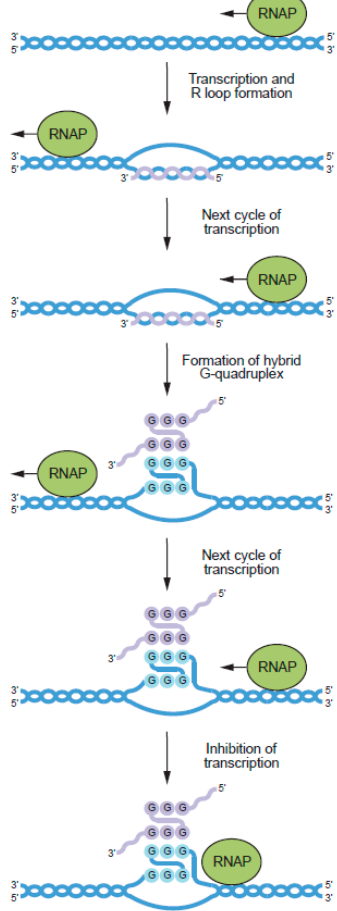
Figure 10. Model for the regulation of transcription by DNA:RNA hybrid GQs, formed between the noncoding strands of G-rich genes and RNA molecules transcribed from these genes. The newly synthesized RNA transcript is shown in purple. See [130] for more information about this model.